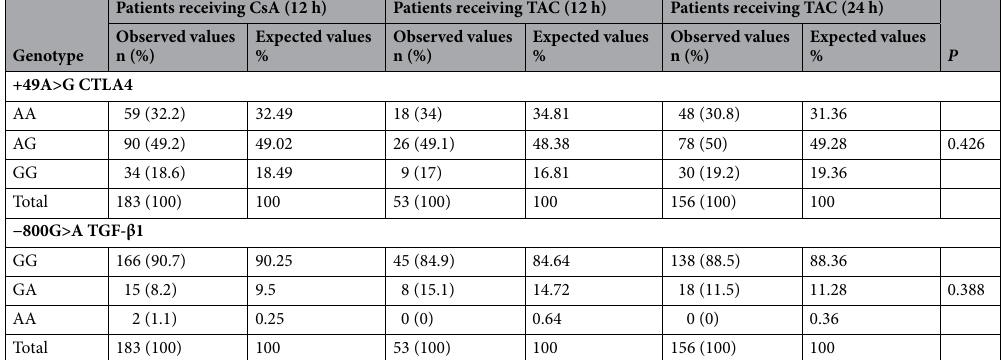
(Table 3). In addition, carriers with the AA and AG genotypes required higher doses of TAC as compared to the GG genotype (AA: 4.83 mg, AG: 5.59 mg vs 3.88 mg, p > 0.05). No relationship between dosage and individual genotypes of the CTLA4 +49A>G polymorphism was found in TAC 24 patients (Table 3). Analysis of the data on TAC dose dependence and genetic variants of the TGF-β1 −800G>A polymorphism revealed that patients with the GA genotype required lower doses of the drug as compared to the GG genotype (TAC 12 h: 3.63 mg vs 5.3 mg, TAC 24 h: 2.38 mg vs 3.29 mg. Comparing the C/D ratio, we showed that in both groups the C/D ratio was higher for patients with the GA genotype (Table 4). Moreover, analysis of the clinical parameters (BMI, systolic and diastolic pressure) and biochemical parameters of the renal profile (potassium, uric, acid creatinine, eGFR) and the CTLA4 and TGF-β1 polymorphisms showed no relation to the risk of organ rejection and indicated a favorable prognosis of the transplanted kidney (Tables 5, 6). It should be emphasized that BMI may affect the risk of new onset diabetes after transplantation, treatment outcomes, including patient and transplant survival, delay in transplant operation, and transplant rejection. According to European Renal Best Practice (ERBP) recommendations, patients with a pre-transplant body mass index (BMI) greater than 30 kg/m 2 should reduce their body weight. In addition, proteinuria, which falls under the risk of transplant rejection criteria, has not been observed in our patients.